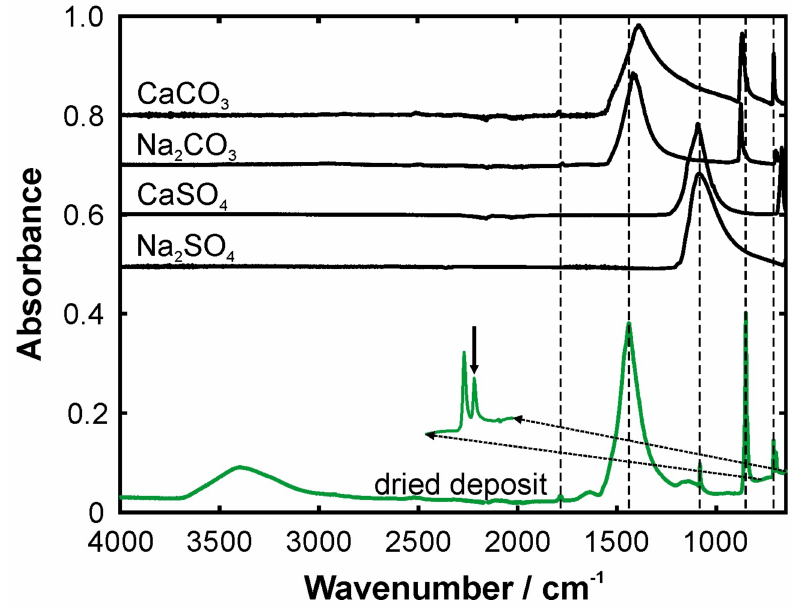
Figure 4. FTIR spectrum of the deposit from the seawater desalination facility in comparison with selected reference spectra. The dashed vertical lines are a guide to the eye. The arrow at the enlarged part indicates the peak at 700 cm − 1